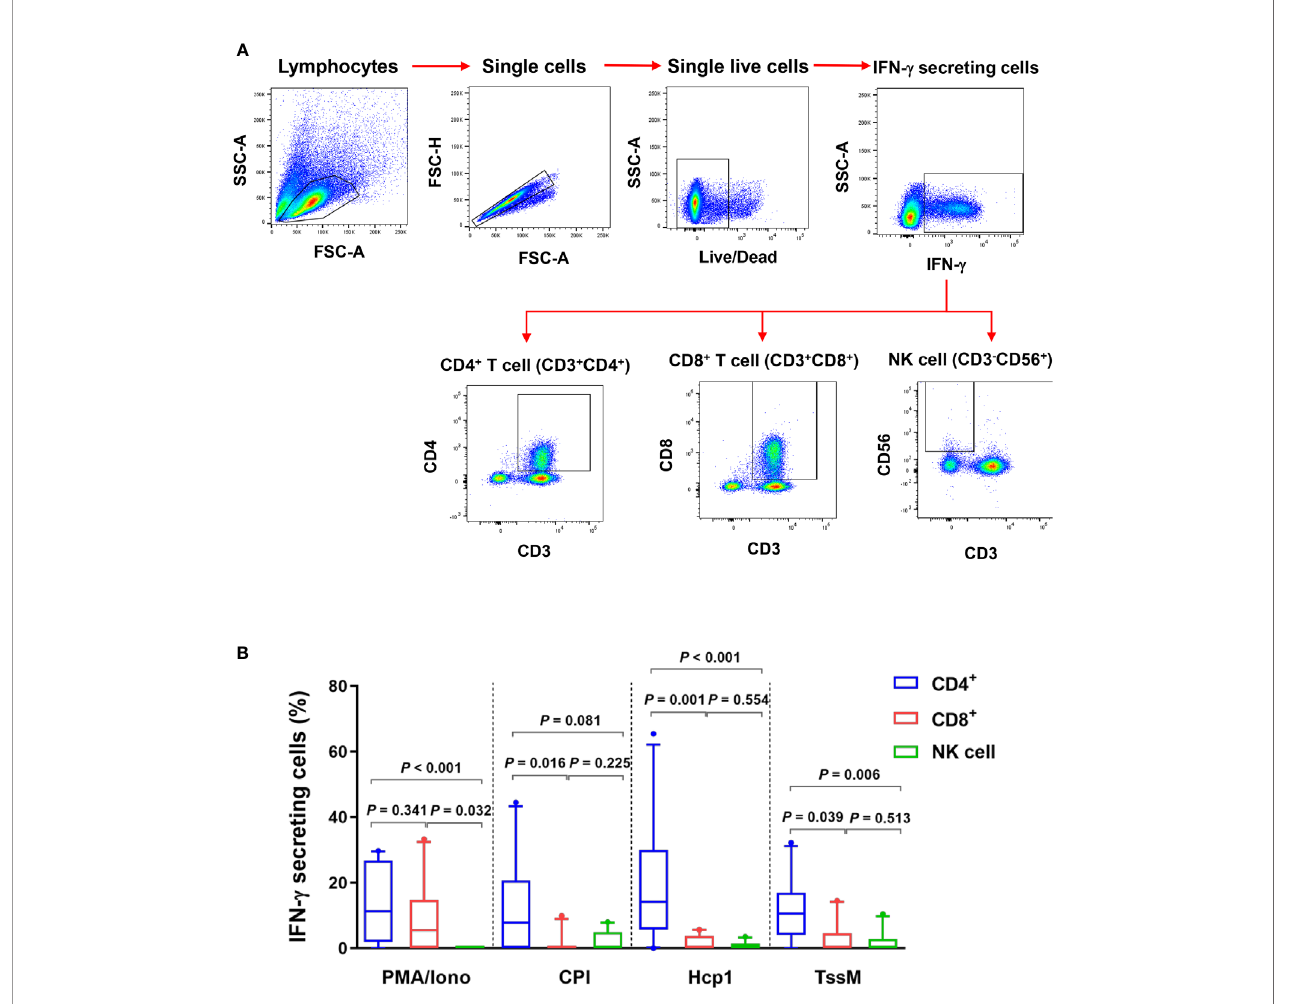
FIGURE 2 | IFN- g producing cells from acute melioidosis patients in response to B pseudomallei Hcp1 and TssM or positive controls [PMA plus ionomycin (PMA/ Iono) and CPI]. (A) Flow cytometry gating strategy for IFN- g secreting CD4 + T cells, CD8 + cells and NK cells. PBMC from one representative melioidosis patient were incubated with positive controls [PMA plus ionomycin (PMA/Iono)] and stained for intracellular IFN- g versus the T cell markers; CD3, CD4, CD8 and NK cell marker; CD56. Frequencies of IFN- g secreting CD4 + T cells, CD8 + T cells and NK cells were identi fi ed within total IFN- g secreting cells. (B) PBMC from 10 melioidosis patients were stimulated with the proteins and controls for 6 hours and then stained for intracellular IFN- g . Frequencies of CD4 + T cells, CD8 + T cells and NK cells within total IFN- g producing cells are shown. Box plots represent 25 th and 75 th percentile boundaries in the box with the median line within the box; the whiskers indicate the 10 th and 90 th percentiles. Statistical signi fi cance between groups was determined using the Mann-Whitney